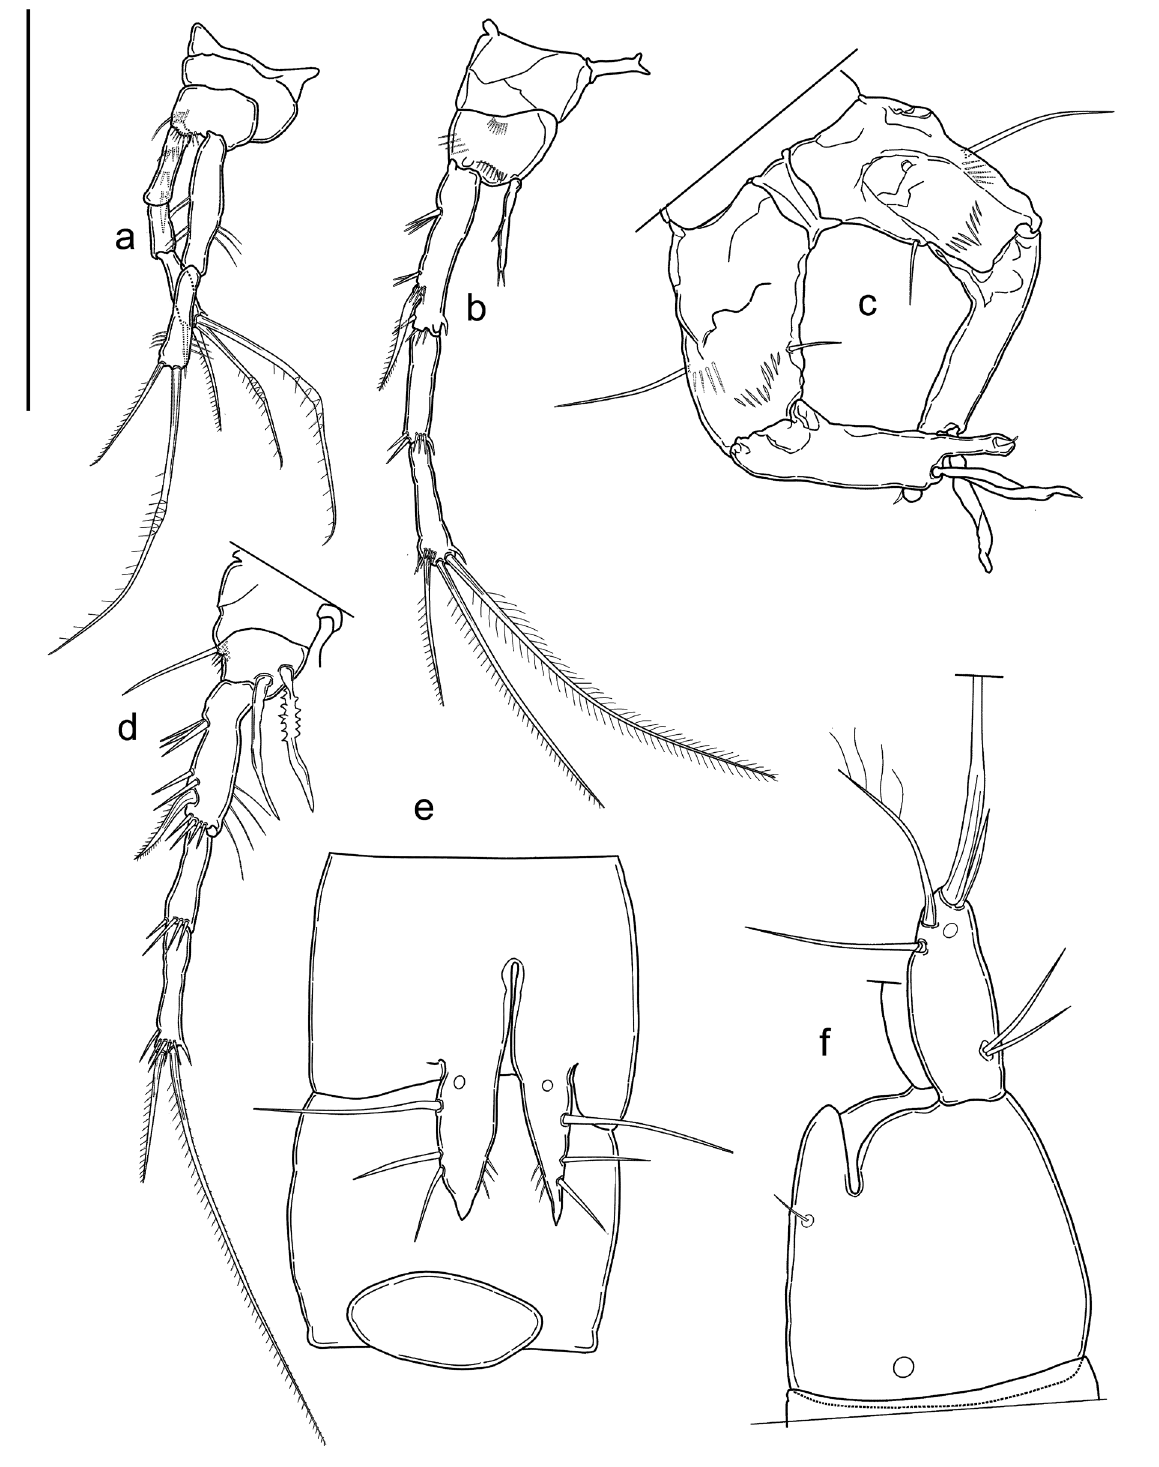
Fig. 13. Proserpinicaris specincola Bruno & Cottarelli sp. nov. (NHMUK). a . ♂, P1, posterior view. b . ♂, P2, posterior view. c . ♂, P3, posterior view. d . ♂, P4, anterior view. e . ♂, P5, P6, first and second urosomites, ventral view. f . ♀, anal somite, anal operculum and caudal rami, lateral view. Scale bar: 50